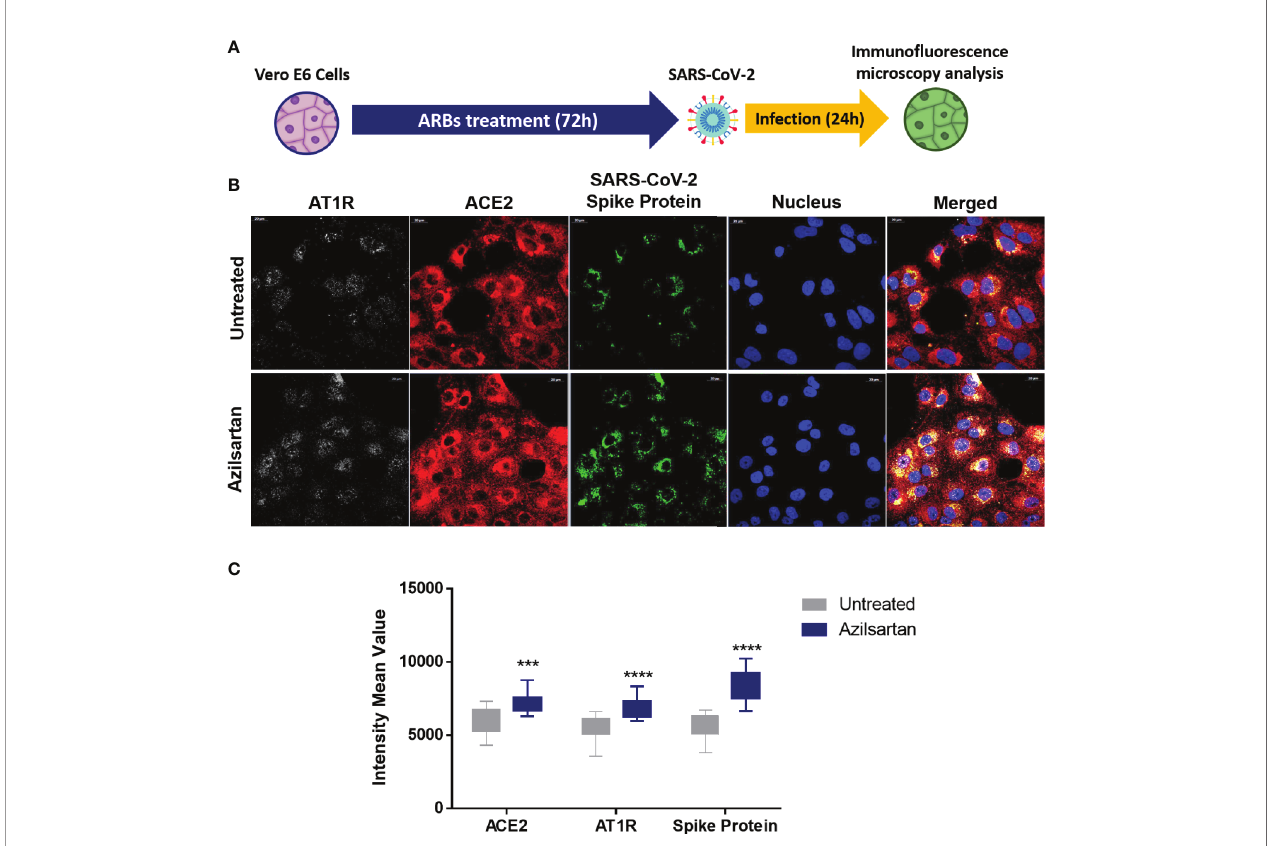
FIGURE 4 | Modulation of cell surface-expressed ATR1 and ACE2 molecules in Vero E6 cells infected with SARS-CoV-2 (24 h.p.i) and treated with Azilsartan (15 µM) for 72 hours by immuno fl uorescence microscopy. (A) Schematic fl ow of the analysis: Vero E6 cells were treated with various ARBs (the MTT assay previously de fi ned non-cytotoxic concentrations: Azilosartan 15µM; Eprosartan 30µM; Irbesartan 60µM; Losartan 7µM; Olmesartan 15µM; Telmisartan 7µM; Valsartan 7µM) for 72 hours and were subsequently infected for analysis of ACE2 and ATR1 on treated and infected cells, 24 hours post-infection (h.p.i.). (B) The panel presents SARS- CoV-2 infected cells after incubation with Azilsartan (15 µM) and evaluation of fl uorescence corresponding to the ATR1, ACE2, viral spike protein, and the nucleus of the cells. The merge of the images is displayed at the right of the panel. Images were acquired using a confocal microscope (Zeiss LSM 800) with a 63X/1.4 oil objective. (C) Quantitative representation of Mean Fluorescence corresponding to ATR1 and ACE2 molecules expression on VERO E6 cells treated or not treated with Azilsartan and SARS-CoV-2 in the cells. *** P < 0.001; **** P <